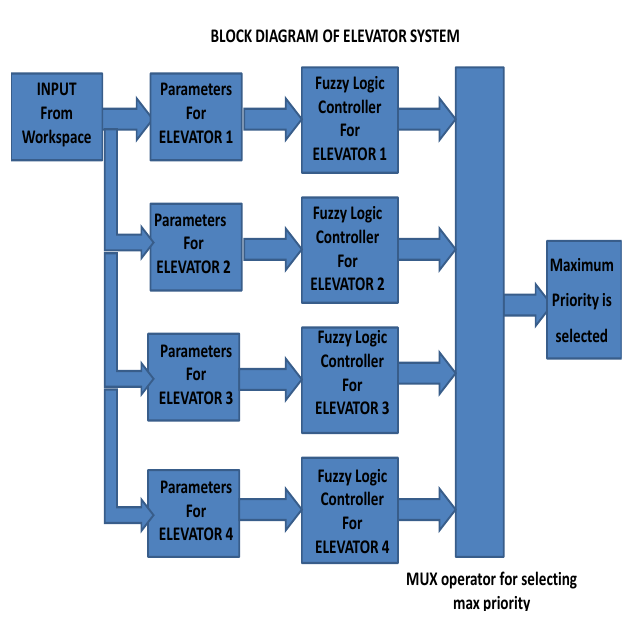
Figure 2. Block diagram of the simulation technique